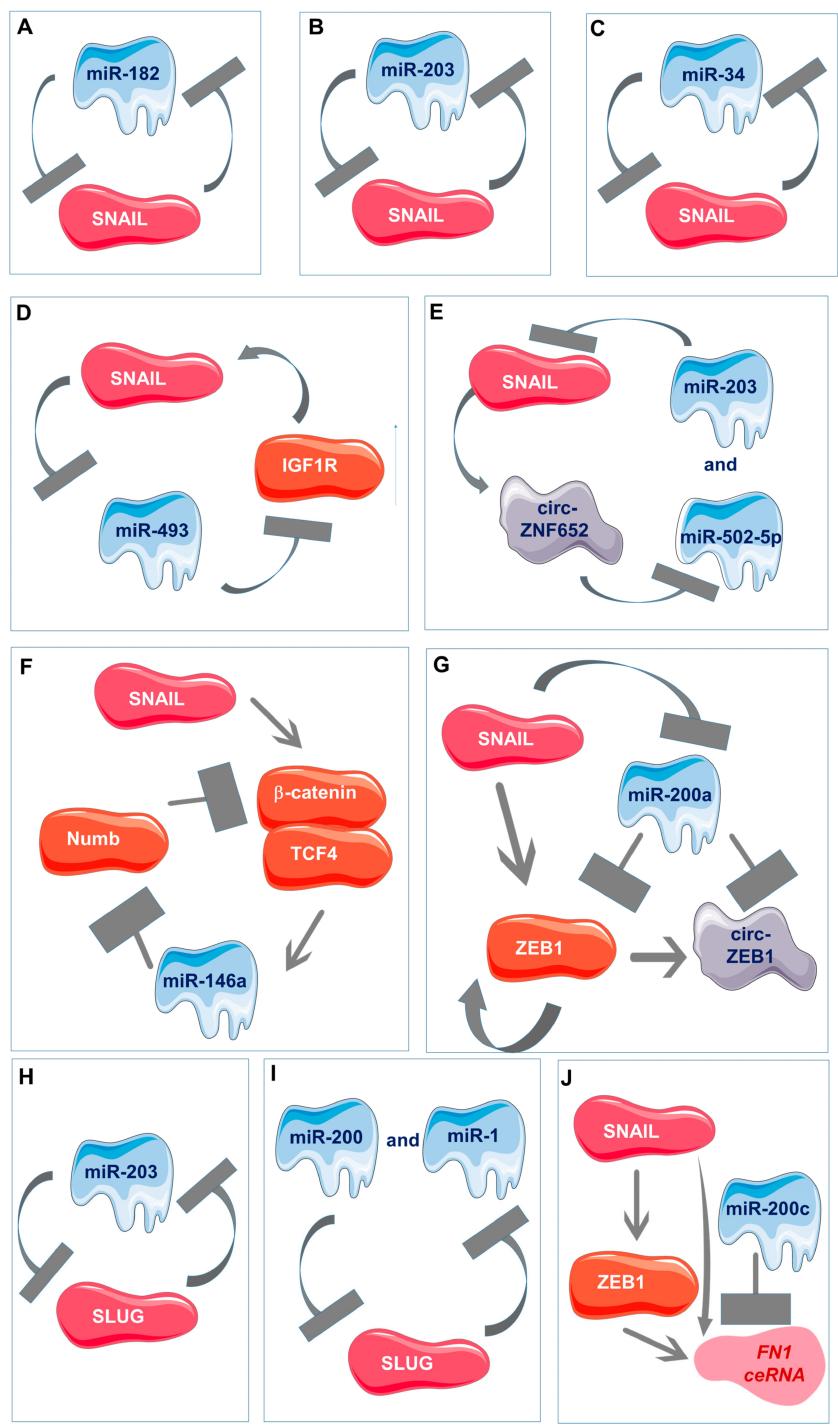
Figure 5. Multi-component feedback loops and multi-component signaling networks involving SNAIL and non-coding RNAs. ( A ) Negative regulation between SNAIL and miR-182. ( B ) Negative regulation between SNAIL and miR-203. ( C ) Negative regulation between SNAIL and miR-34. ( D ) Feedback loop between SNAIL, miR-493, and IGF1R. ( E ) Feedback loop between SNAIL, circ-ZNF652, miR-203, and miR-502-5p. ( F ) Signaling pathway involving SNAIL, β -catenin, miR-146a, and Numb. ( G ) Signaling pathway involving SNAIL, ZEB1, miR-200a, and circ-ZEB1. ( H ) Negative regulation between SLUG and miR-203. ( I ) Negative regulation among SLUG, miR-1, and miR-200. ( J ) Signaling pathway involving SNAIL, ZEB1, miR-200c, and FN1